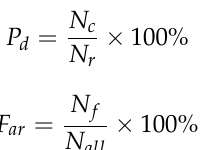
Figure 7. The results of processing of the 551st frame. The green rectangles highlight the detected moving targets. ( a )–( f ) correspond to those in Figure 6a–f.